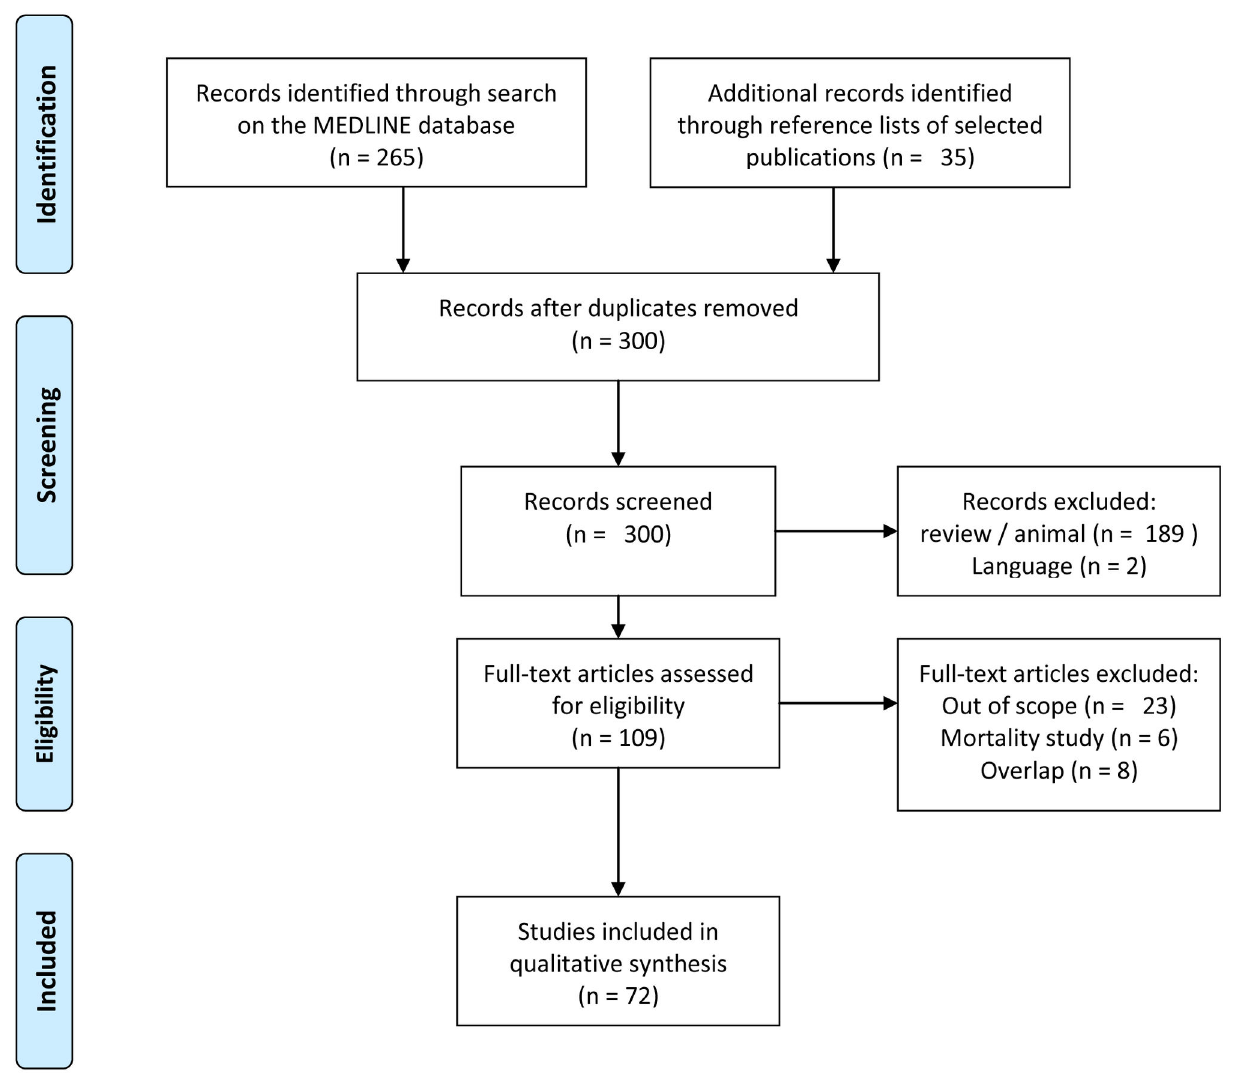
Figure 1. Flow diagram of identified articles published between 1990 and 2012.